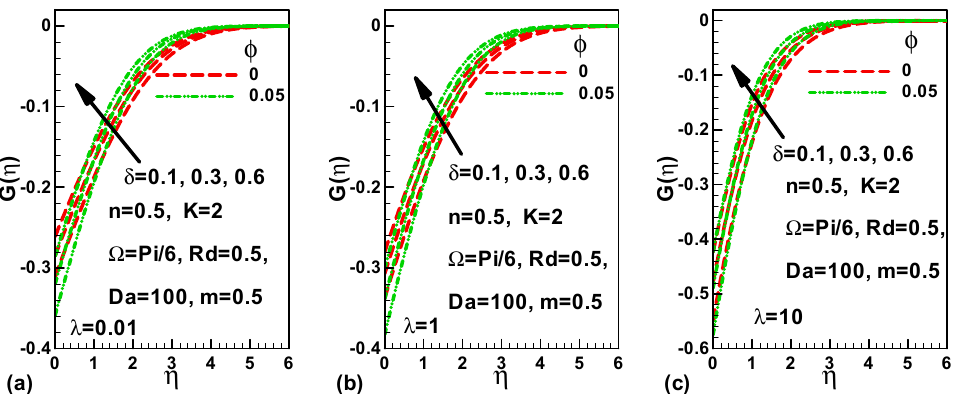
Figure 7. Variation of dimensionless microrotation with slip parameter and solid volume fraction of nanoparticles for ( a ) forced convection, ( b ) mixed convection, and ( c ) free convection.